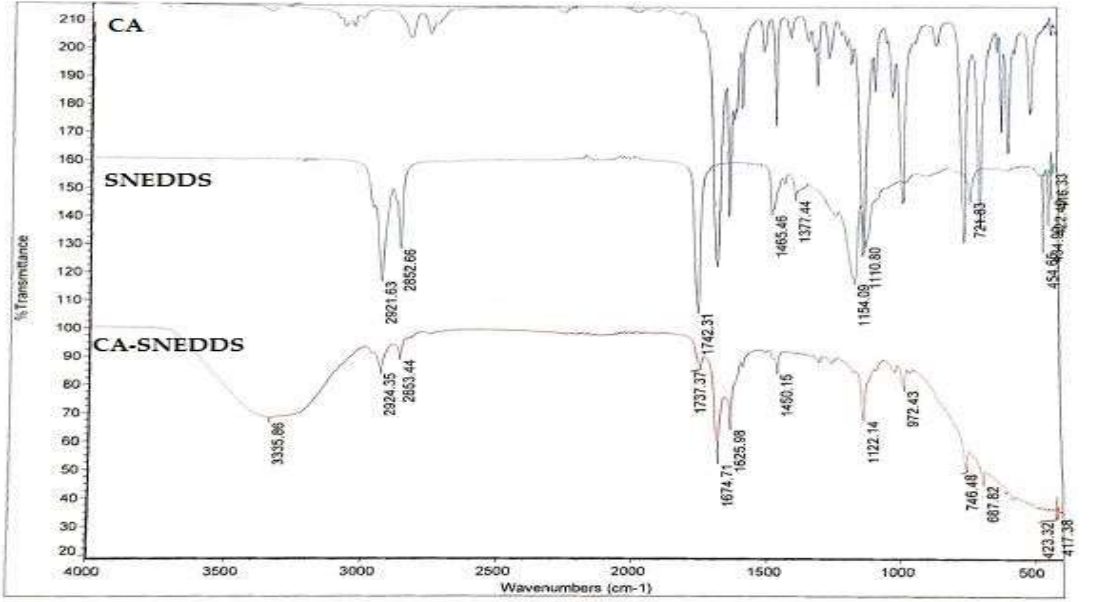
Figure 1. FT-IR analysis of CA, SNEDDS, CA-SNEDDS. Note: CA = pure cinnamaldehyde; SNEDDS = SNEDDS without CA; CA-SNEDDS = SNEDDS with CA. SNEDDS = SNEDDS without CA; CA-SNEDDS = SNEDDS with CA.